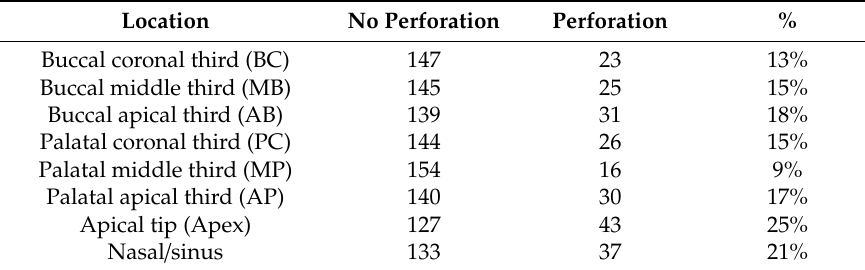
Table 2. Number of perforation at different MDI sites.